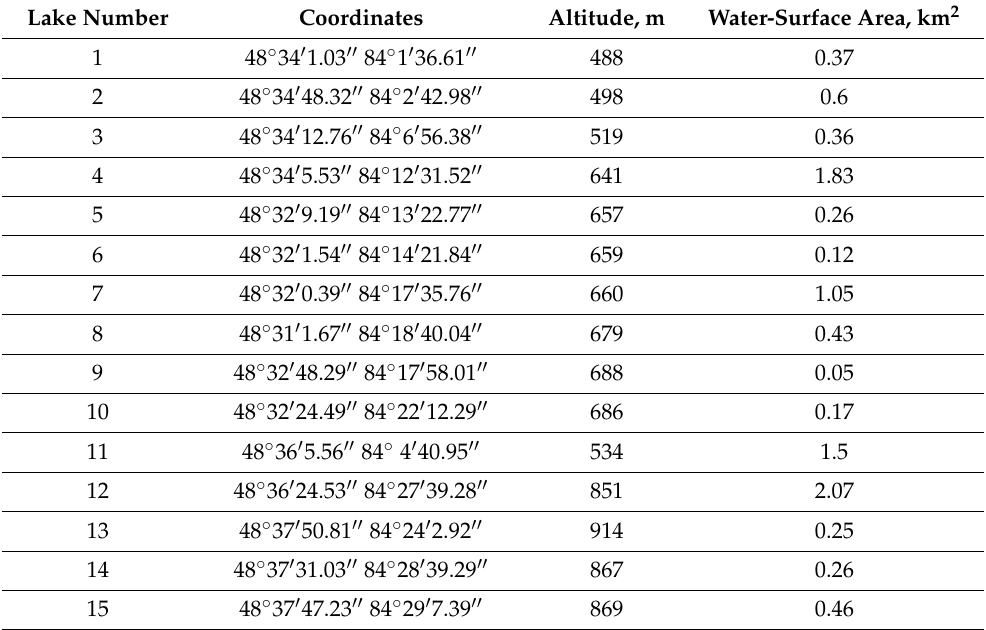
Table 1. Summary on the wells of Burabay granitoid-rock mass. Lake Number Coordinates Altitude, m Water-Surface Area, km